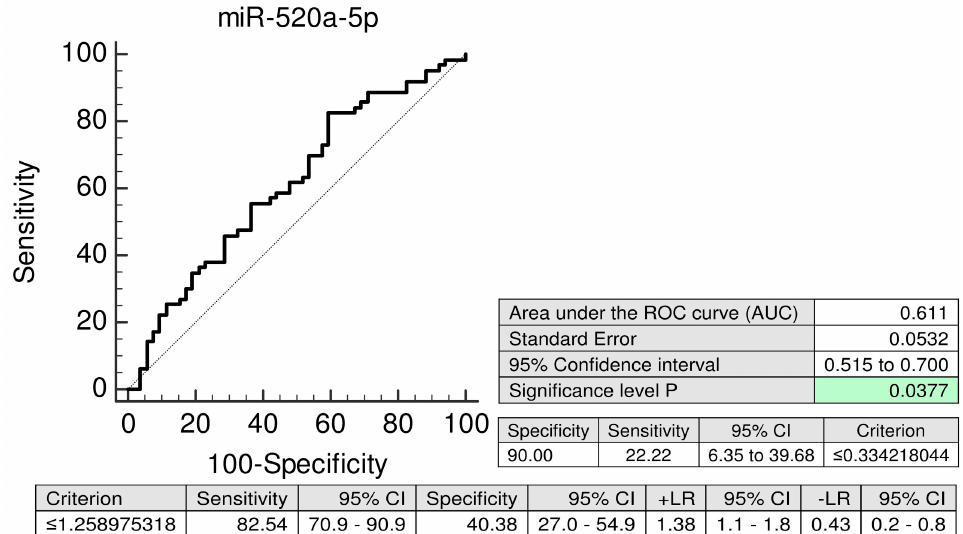
Figure 7. ROC curves—evaluation of the potential of the first trimester miR-520a-5p biomarker screening in plasma exosomes to predict subsequent onset of FGR. Decreased levels of miR-520a-5p were detected in women destinated to develop FGR when the comparison to the controls was performed. FGR: fetal growth restriction.